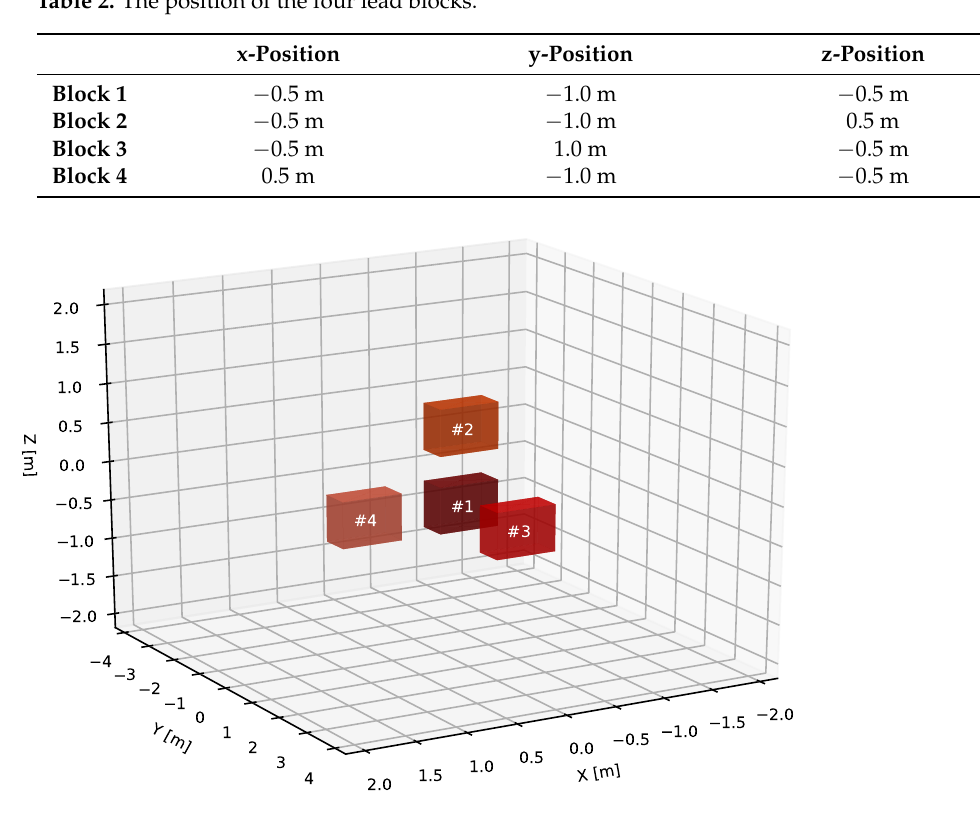
Figure 11. A 3D visualization of the location of the four lead cubes in test scenario